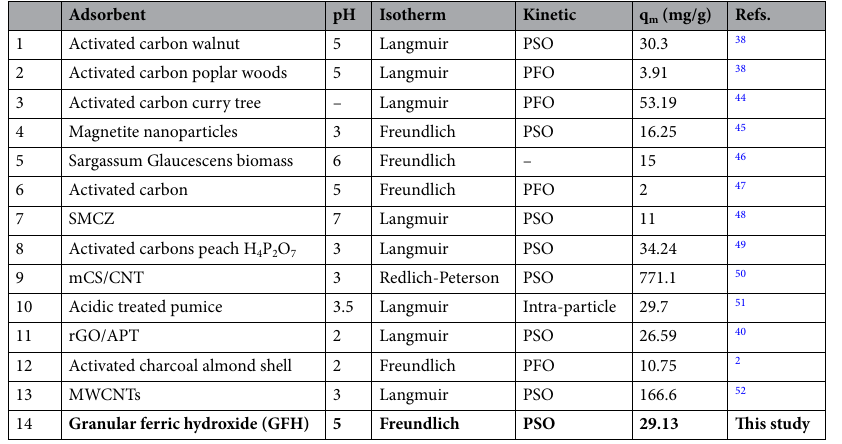
Table 10. Comparison of maximum adsorption capacity of AR18 between various adsorbents. Significant values are in [bold/italics].